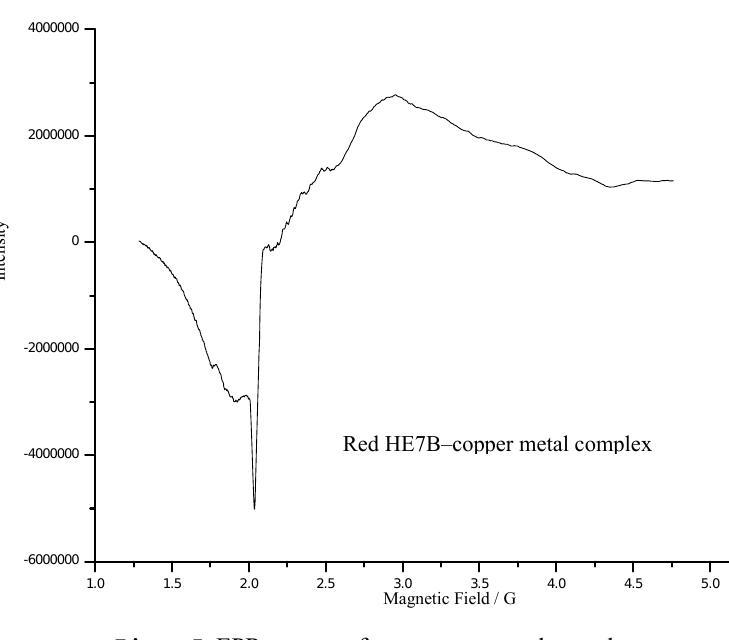
Figure 5. EPR spectra of azo-copper metal